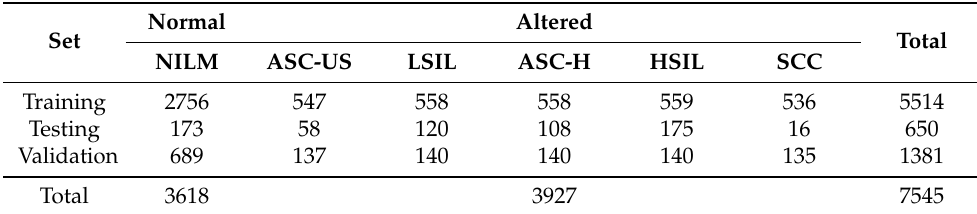
Table 2. The numbers of images from each class after balancing and data augmentation for the training, validation, and testing sets in the two-class classification.